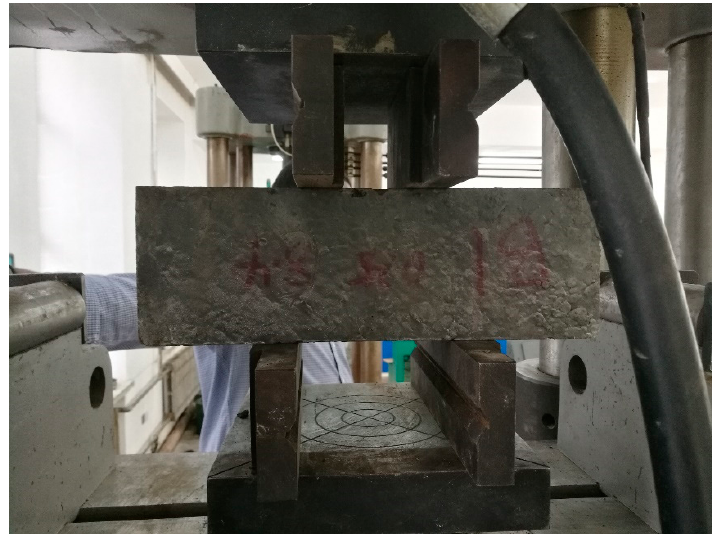
Figure 1. Direct shear test experimental set-up.